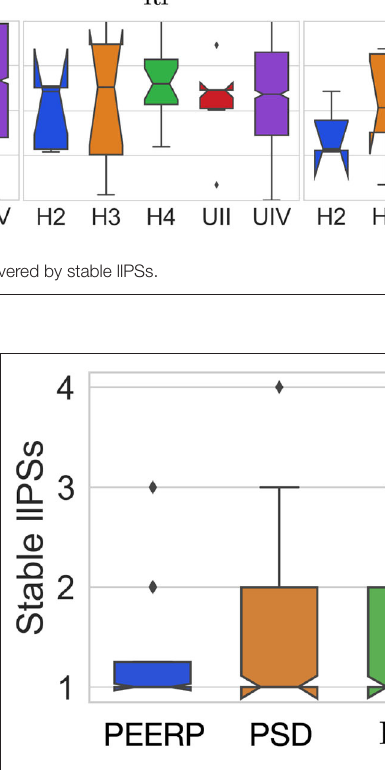
FIGURE 11 | Number of stable llPSs per simulation with the different induction